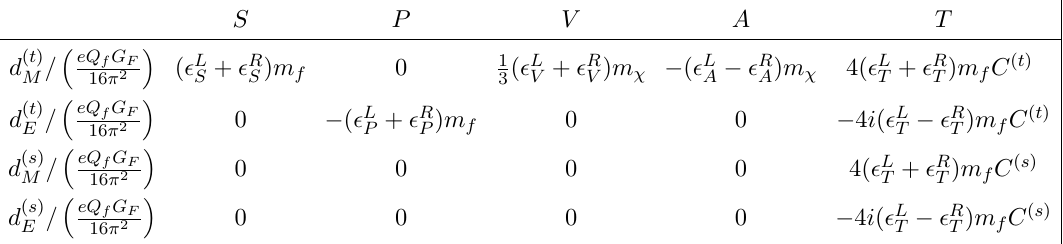
Table 2 . Loop-induced electromagnetic dipoles obtained for the various operators assuming a t - or s -channel energy dependence for their coupling strengths. Here d ( t ) and d ( t ) are generated by M E the t -channel G ( t ) , and d ( s ) and d ( s ) by the s -channel G ( s ) — see in eq. (3.7). C ( t ) and C ( s ) are X M E X given by C ( t ) ≡ 1 + log( m 2 /m 2 ) , C ( s ) ≡ 1 + log( µ 2 /m 2 ) , with µ and ε defined by the f φ f ε